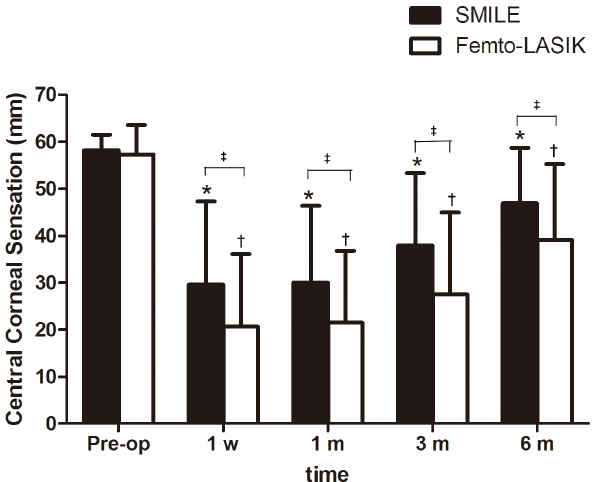
Figure 4. Time dependent changes in the mean central corneal sensations (mean ± SD, mm) after small incision lenticule extraction (SMILE) and femtosecond LASIK (femto-LASIK). *Significantly lower than the preoperative level (SMILE; P , 0.05). { Significantly lower than the preoperative level (femto-LASIK; P , 0.05). ` Significantly different between groups ( P ,